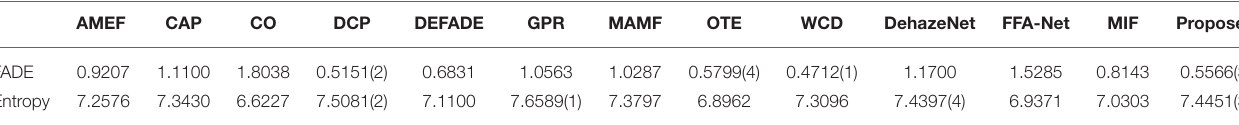
TABLE 5 | Evaluation of two objective indexes in the tunnel image ( Figure 9 ) defogging experiment. AMEF CAP CO DCP DEFADE FFA-Net MIF Proposed